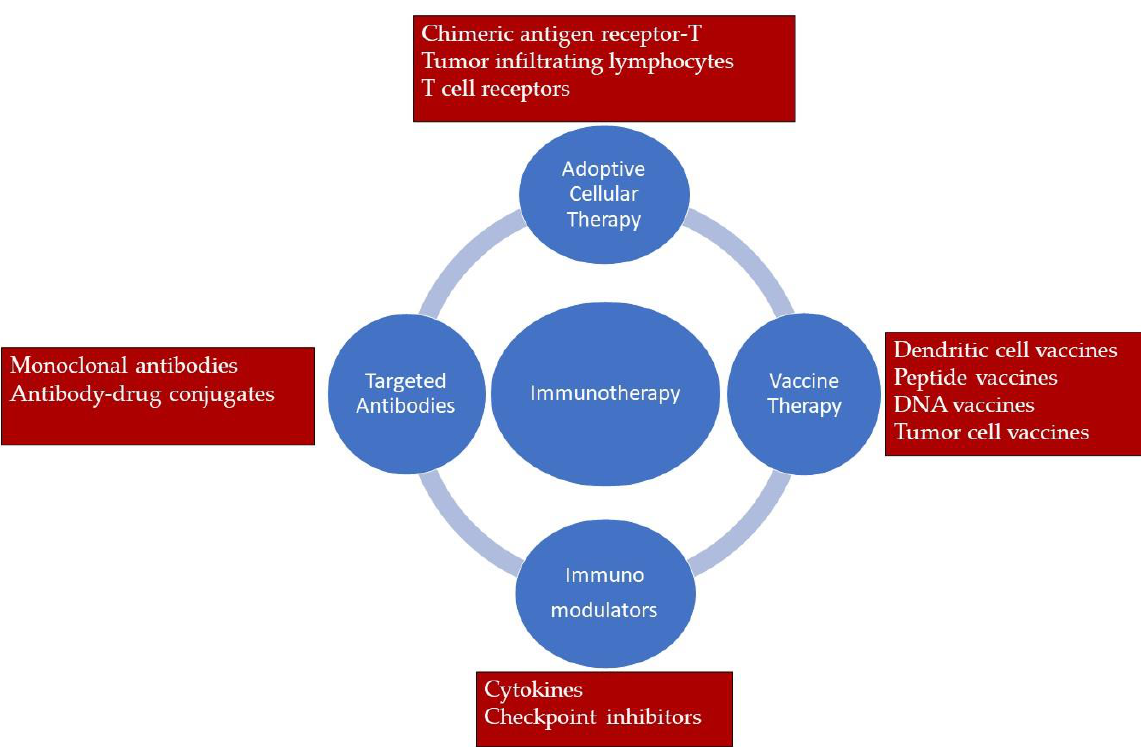
Figure 3. Immunotherapy approaches for cancer treatment